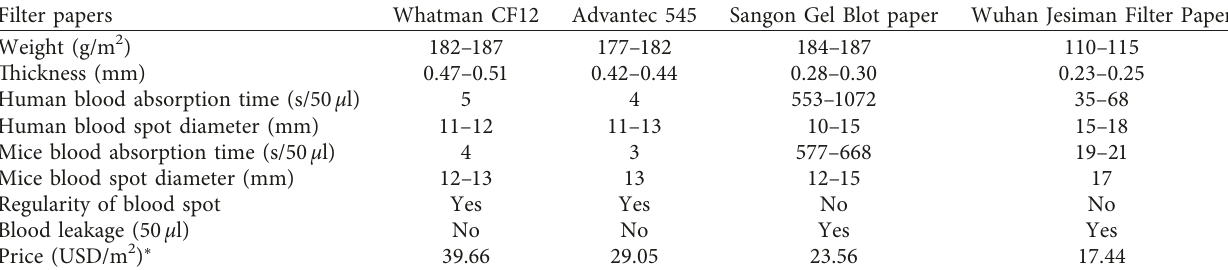
Table 1: Characteristics of four types of filter